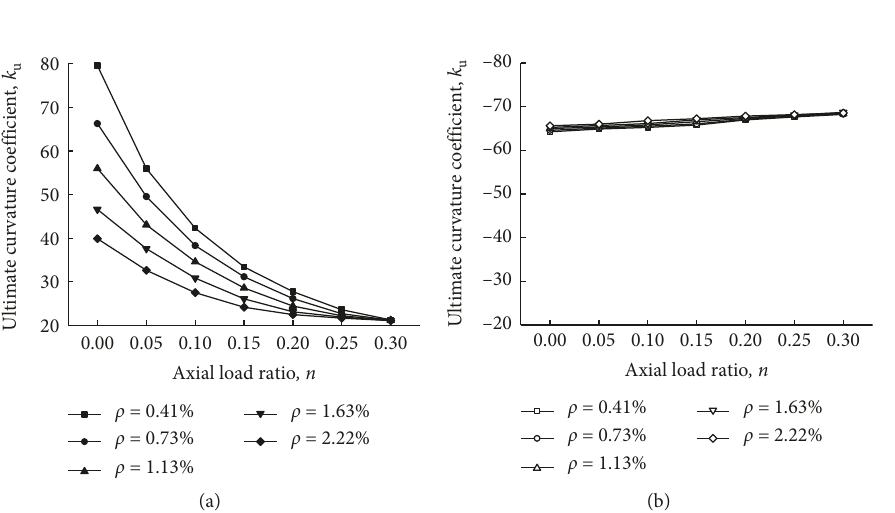
Figure 13: Variations in the ultimate curvature coefficient with the axial load ratio at different boundary longitudinal reinforcement ratios. (a) Flange in tension. (b) Flange in compression.